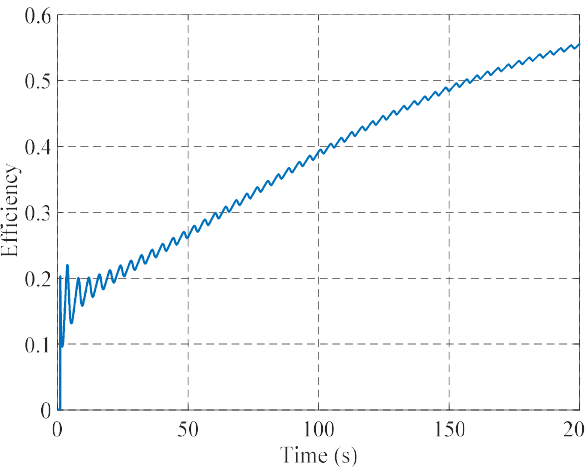
Figure 13. The efficiency of hydraulic PTO. The efficiency is 0.58 when the hydraulic PTO system is stable.